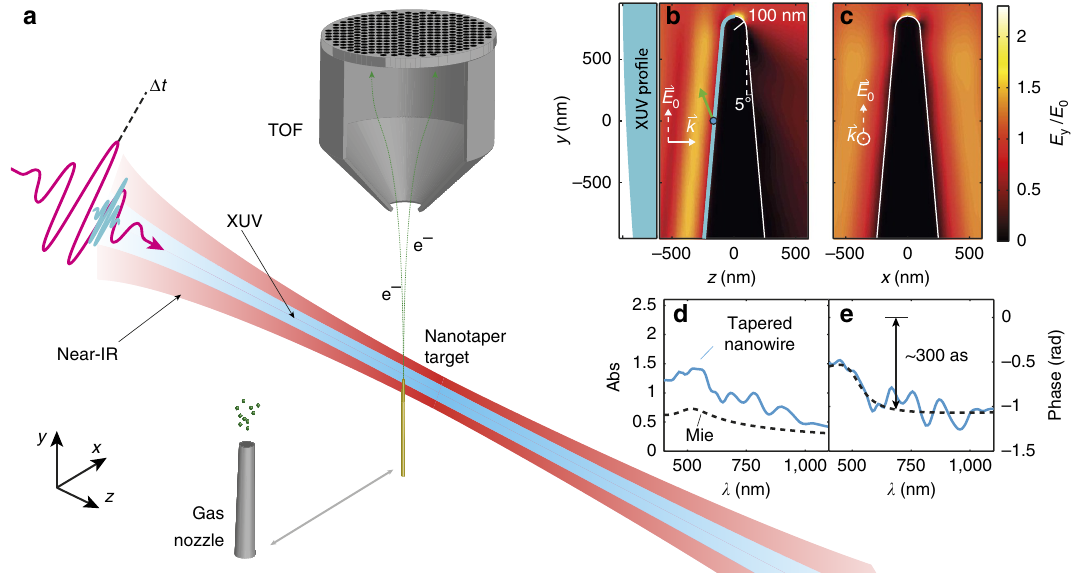
Figure 1 | Attosecond nanoscale near-field sampling. ( a ) Experimental set-up: few-cycle near infrared (NIR) and isolated extreme ultraviolet (XUV) attosecond pulses with variable delay are focused onto a gold nanotaper. High-energy electrons are emitted via XUV photoionization and subsequently accelerated in the local near fields. The delay-dependent final kinetic energy is measured using a time-of-flight (TOF) spectrometer. The nanotaper can be replaced by a gas target. ( b , c ) Maximal normalized local field strengths of the component parallel to the taper axis ( b ) along the laser propagation direction and ( c ) perpendicular to it as obtained from FDTD simulations. The green arrow shows the maximum electron detection angle. The blue lineout illustrates the XUV photoemission area. ( d , e ) Response function of the probed E y -component (axis of laser polarization and TOF spectrometer) for a representative point (as indicated in b ) at the nanotaper, showing the ( d ) absolute value and ( e ) phase dependence on the wavelength. The response of the shank is close to an infinite cylinder with a diameter of 200nm calculated using Mie theory (black dashed line). Slight position-dependent oscillations occur due to a plasmon launched at the tip apex (Supplementary Note 4 and